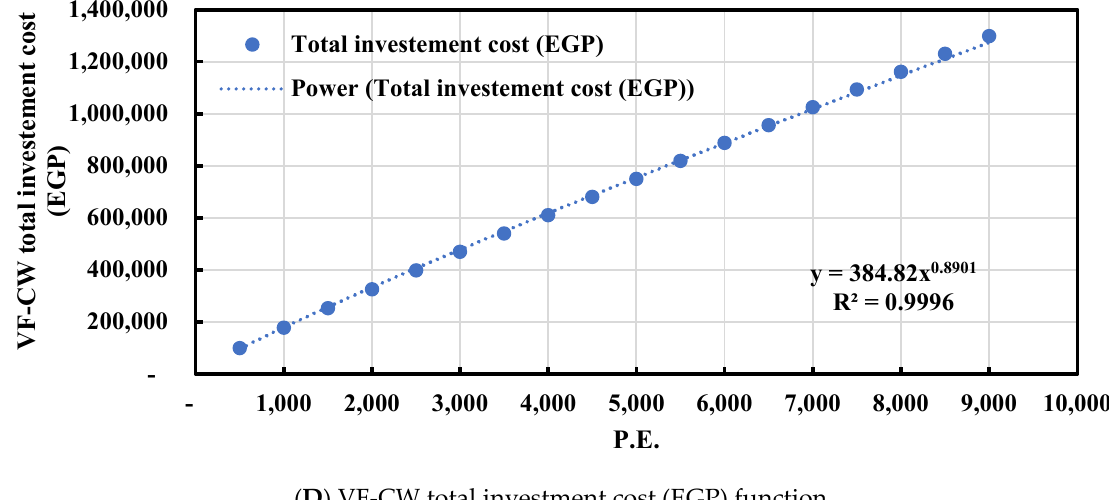
Figure 6. Investment cost (EGP) per capita ( P.E. ) and total investment cost (EGP) design curves for HSSF-CW and VF-CW treatment systems.